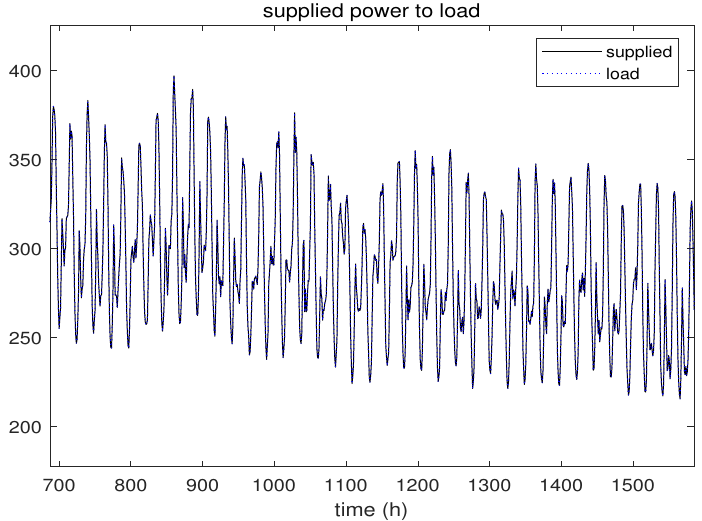
Figure 11. Comparison between supplied energy and